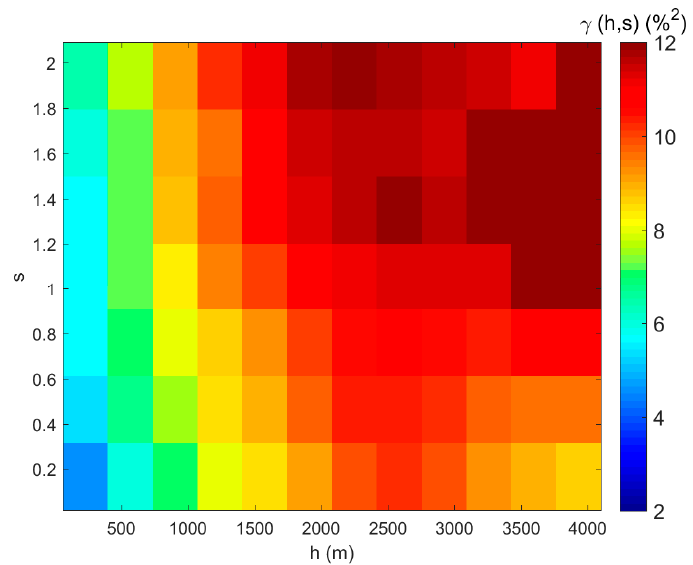
Figure 6. Semivariance of sampled soil moisture data with respect to spatial and spectral distance: the X -axis is spatial distance, the Y -axis is spectral distance, and the color in each grid represents the average semivariance value of the soil moisture; only valid semivariance data were kept for the semivariogram fitting ( h ≤ 4000 m and s ≤ 2).